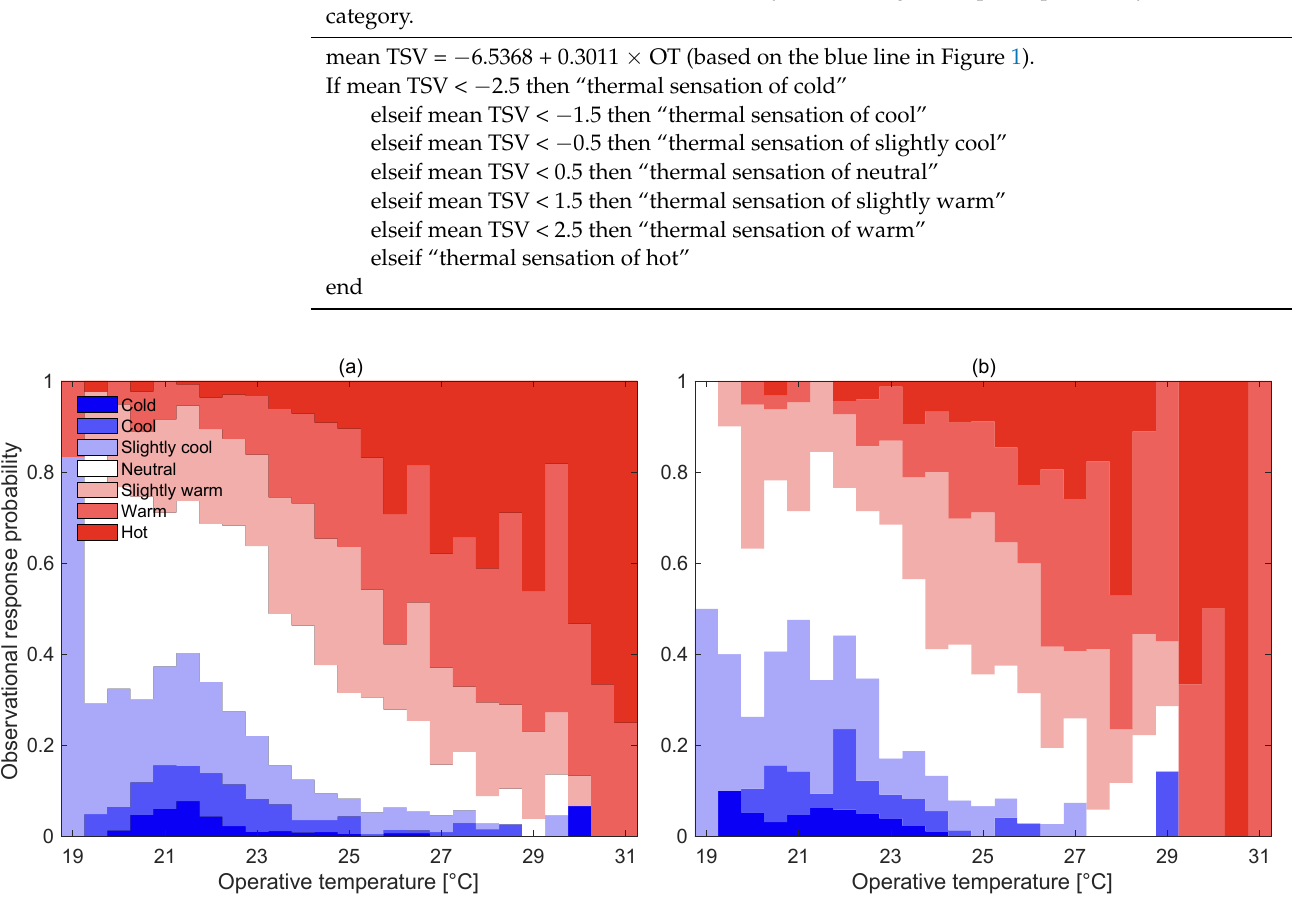
Figure 4. Thermal sensation profiles based on the ( a ) conventional and ( b ) probabilistic models. Algorithm 1. Pseudocode for deterministically establishing the response probability for each TSV category. mean TSV = −6.5368 + 0.3011 × OT (based on the blue line in Error! Reference source not found. ). If mean TSV < −2.5 then “thermal sensation of cold” elseif mean TSV < −1.5 then “thermal sensation of cool” elseif mean TSV < −0.5 then “thermal sensation of slightly cool” elseif mean TSV < 0.5 then “thermal sensation of neutral” elseif mean TSV < 1.5 then “thermal sensation of slightly warm” elseif mean TSV < 2.5 then “thermal sensation of warm” elseif “thermal sensation of hot”